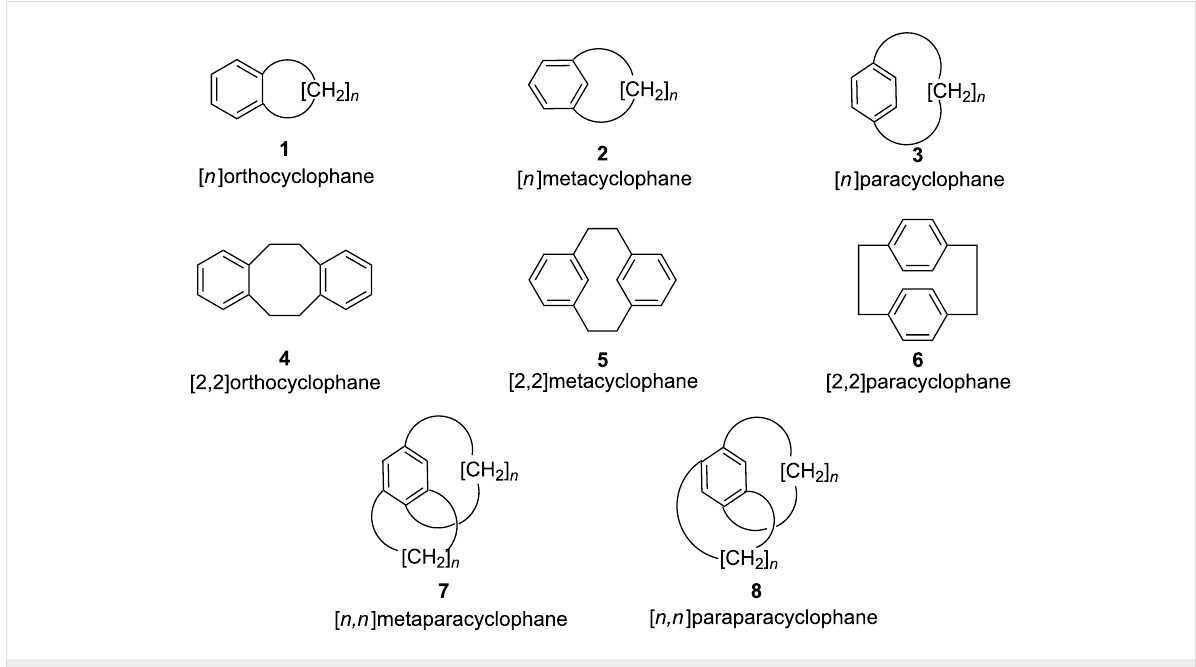
Figure 1: General representation of cyclophanes.